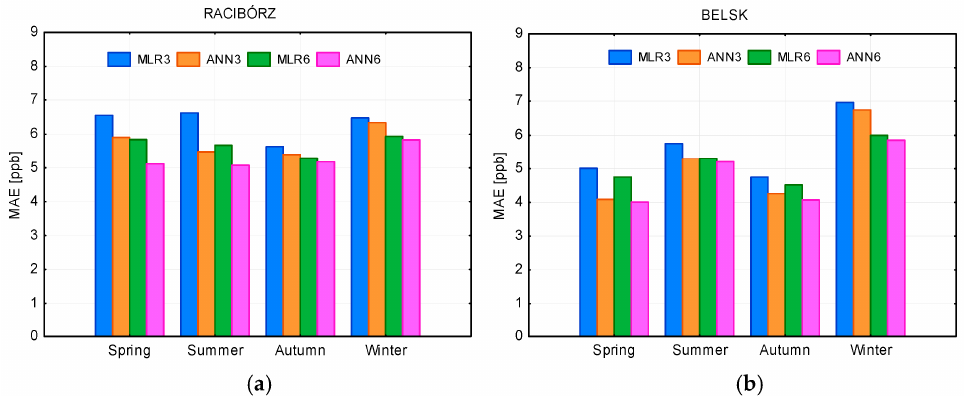
Figure 10. The same as Figure 8 but for mean absolute error (MAE) for Racibórz ( a ) and Belsk ( b ).